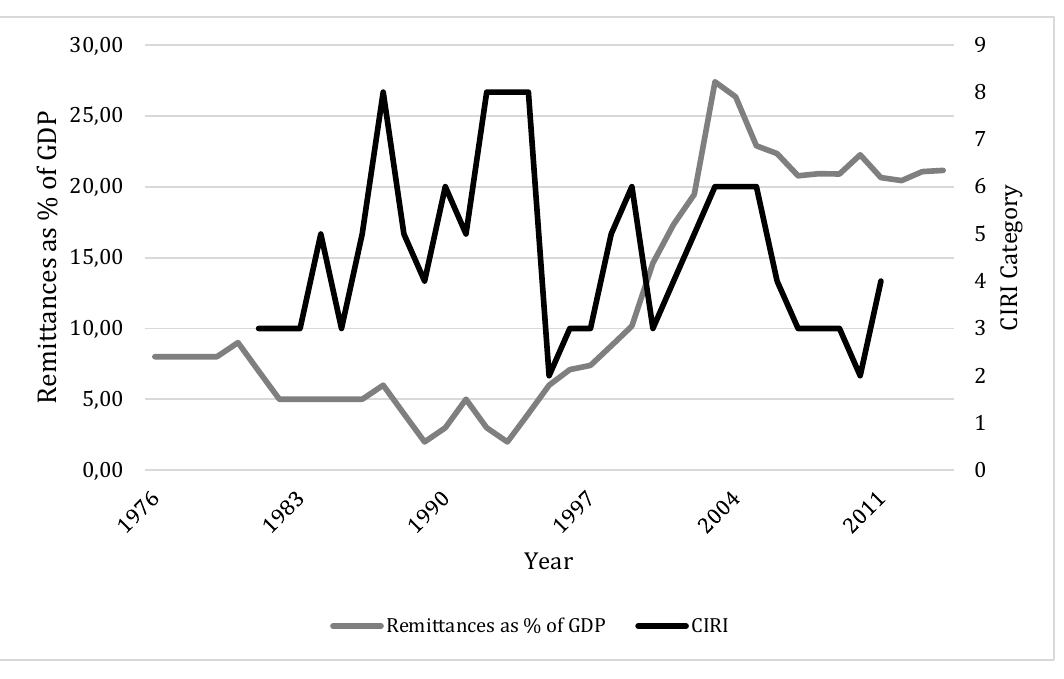
Figure 03. Remittances and CIRI in Haiti